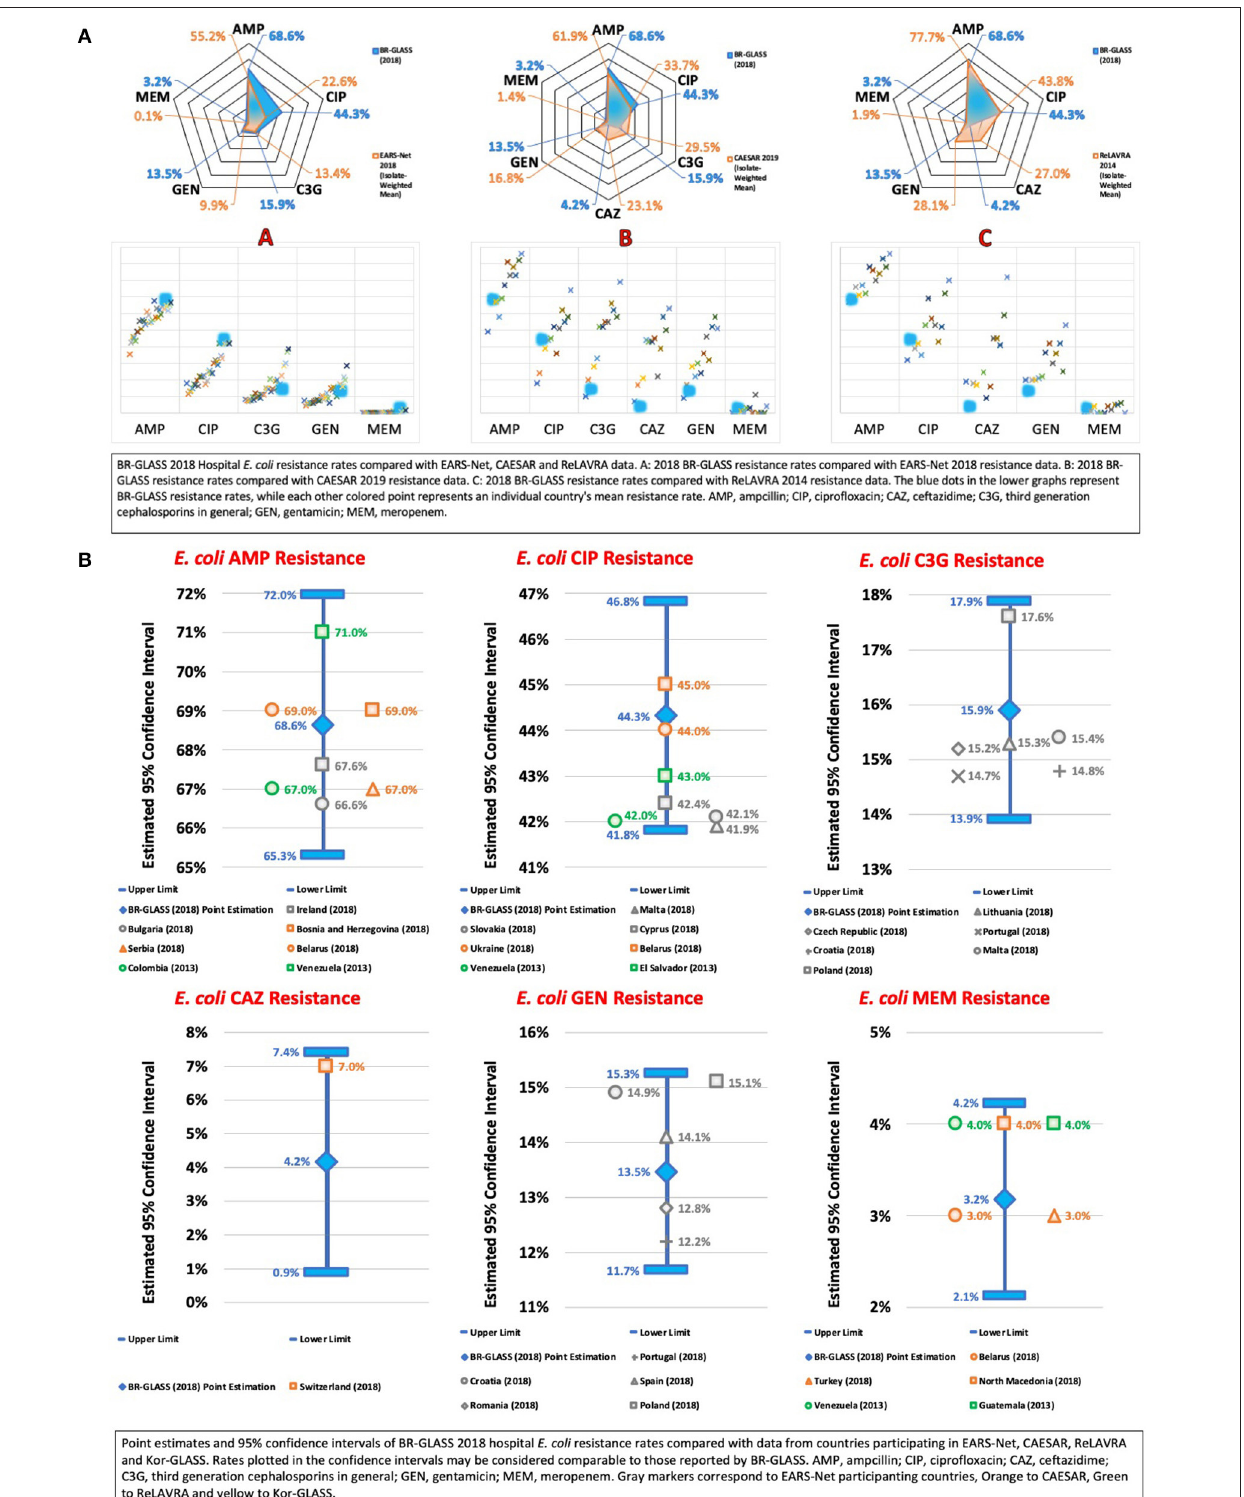
FIGURE 8 | (A) BR-GLASS 2018 Hospital E. coli resistance rates compared with general EARS-Net, CAESAR and ReLAVRA data. (B) BR-GLASS 2018 Hospital E. coli estimated resistance rates with 95% confidence intervals and comparable rates reported in different countries.